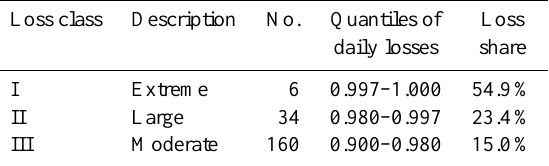
Table 1. The three loss classes defined for the winter half-year. Given are the number of observations, the related quantiles, and the accumulated loss share for the period 1997 to